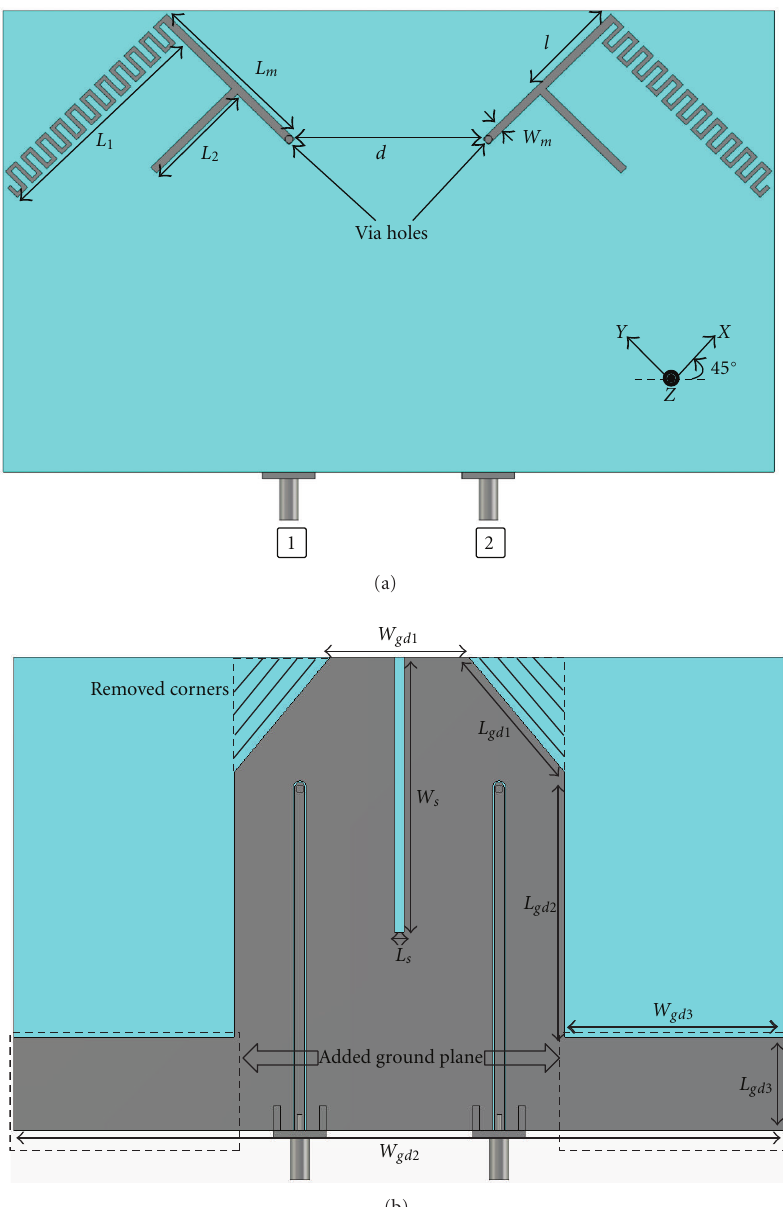
Figure 1: (a) Front view. (b) Back view of one meander bend ending antennas, with added ground plane and slot.